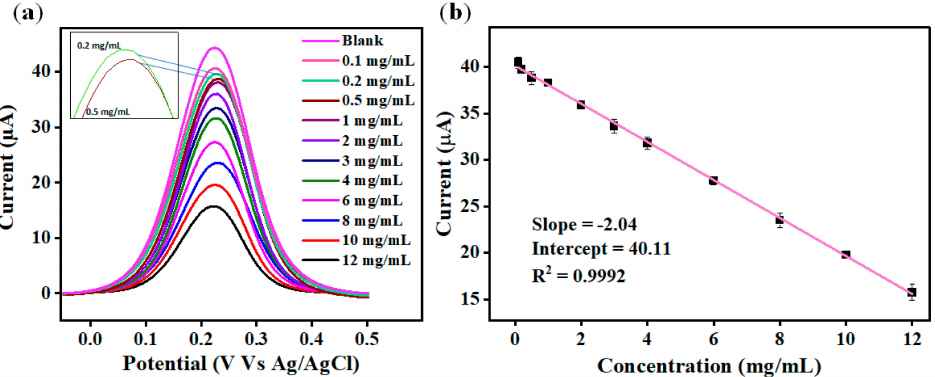
Figure 4. ( a ) DPV curves depicting the responses of the anti − Tf/rGO/ITO immunosensor to different concentrations of Tf; ( b ) calibration curve showing the relationship between the response current of the immunosensor and the varying concentrations of Tf